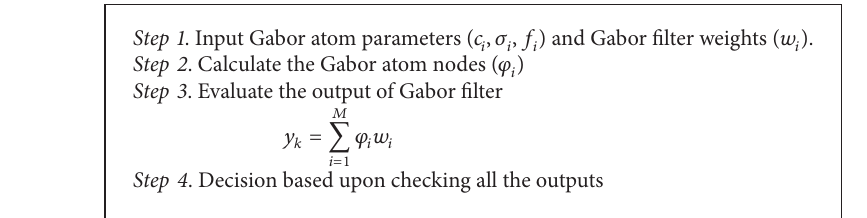
Algorithm 2: (Testing of Gabor filter Network for Modulation